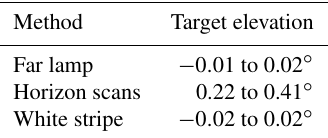
Table 3. Overview of the retrieved target elevations (cid:98) α for the MPIC instrument using three of the methods described in the